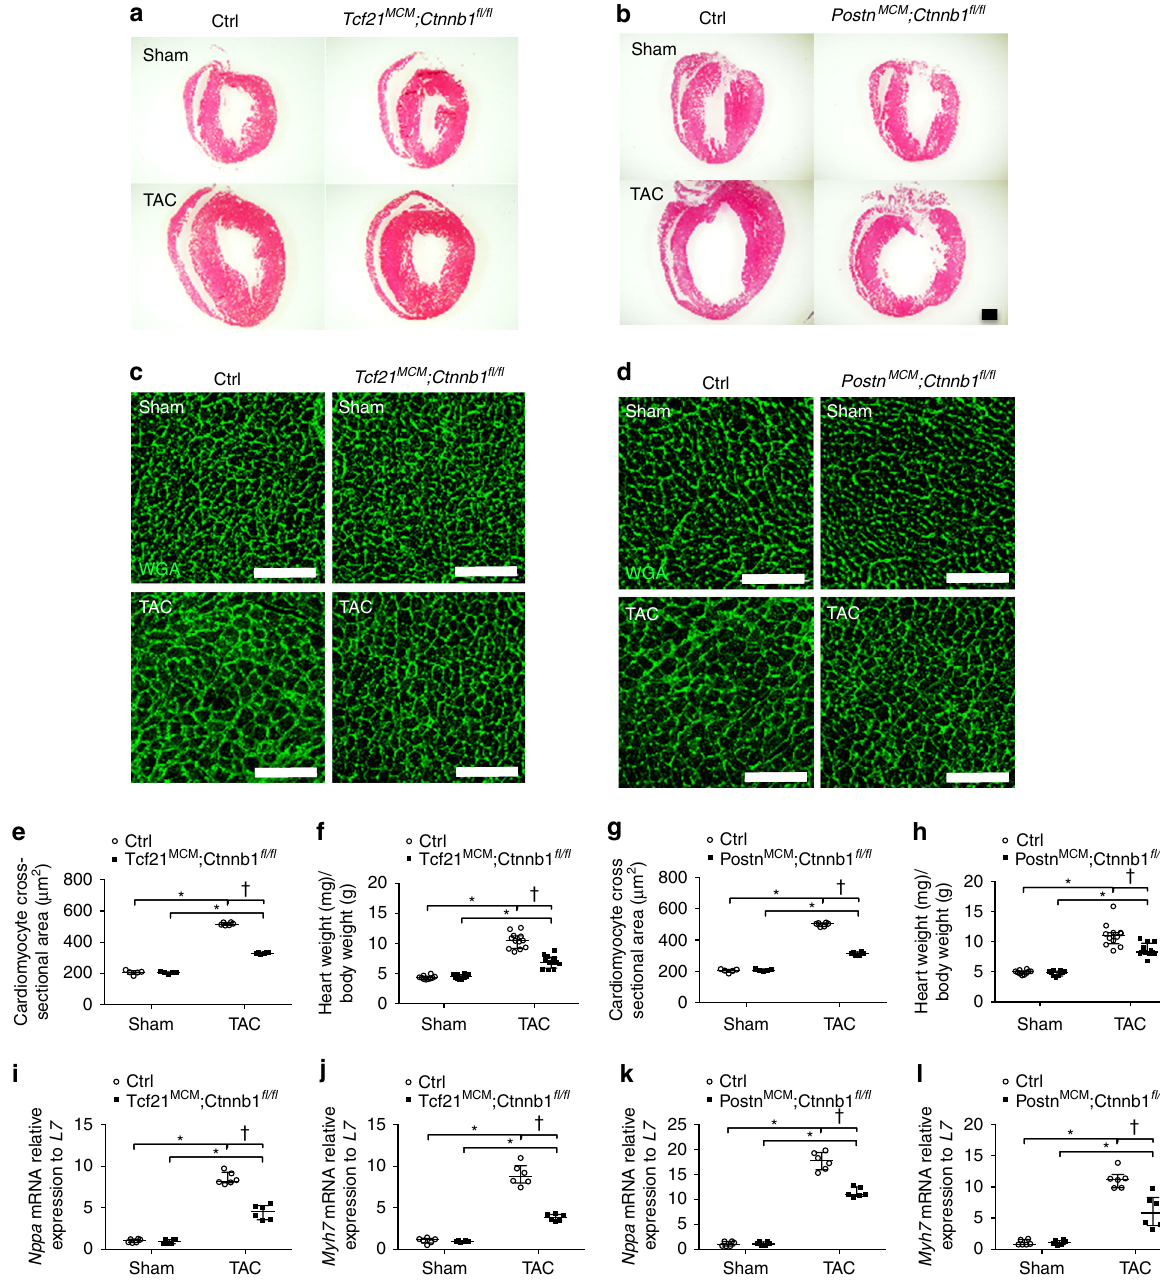
Fig. 3 Loss of β -catenin in Tcf21 or Postn lineage attenuates cardiac hypertrophy 8 weeks post TAC. Representative images of hematoxylin and eosin